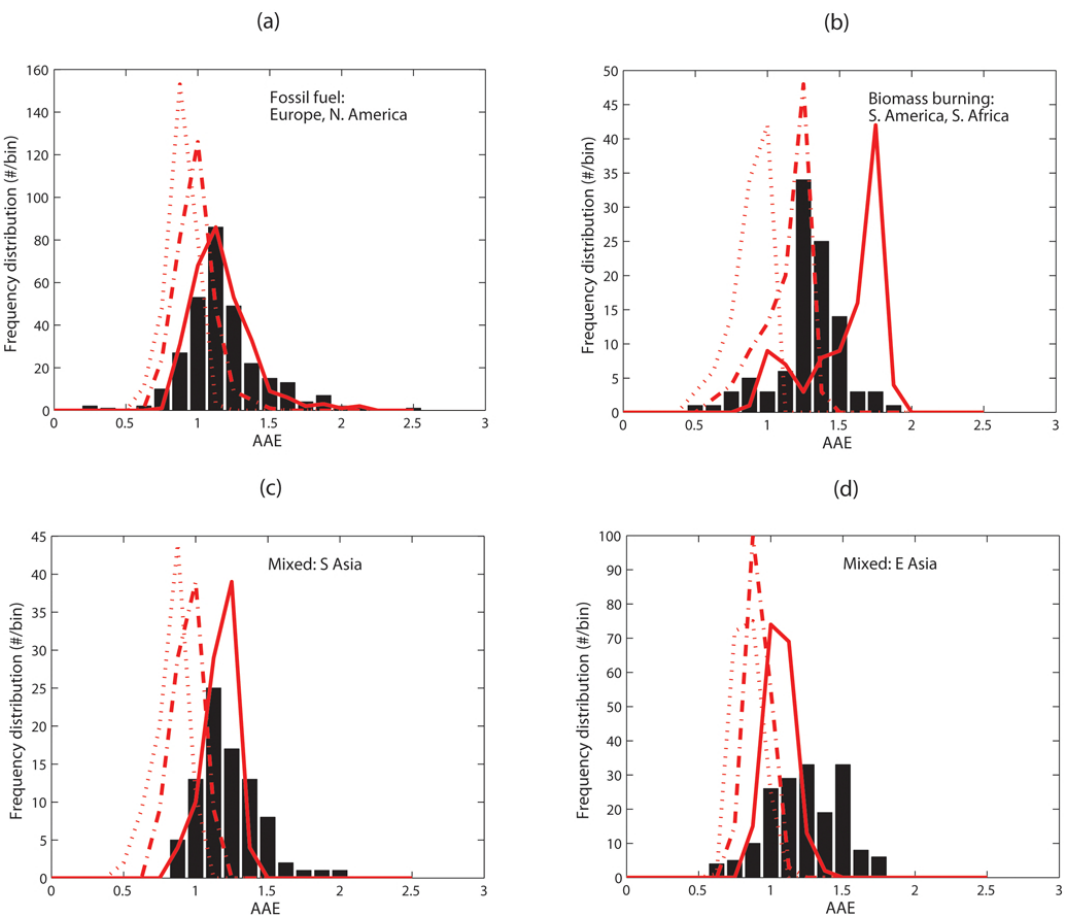
Fig. 6. Frequency distribution of the aerosol absorption Ångström exponent (AAE) at 440–870nm, derived from the AERONET data (bar) and model simulations (in red). Dotted line, for the non-absorbing OC; dash-dot line, for the MOD BrC; solid line, for the STR BrC at 775 total AERONET sites. Distributions are over (a) fossil fuel-dominated Europe and North America, (b) open biomass burning-dominated South America and southern Africa, (c) mixed source region in South Asia, and (d) mixed source region in East